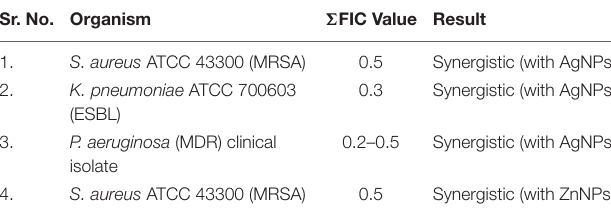
TABLE 6 | Synergistic activity of nanoparticles and gentamicin. Sr. No.